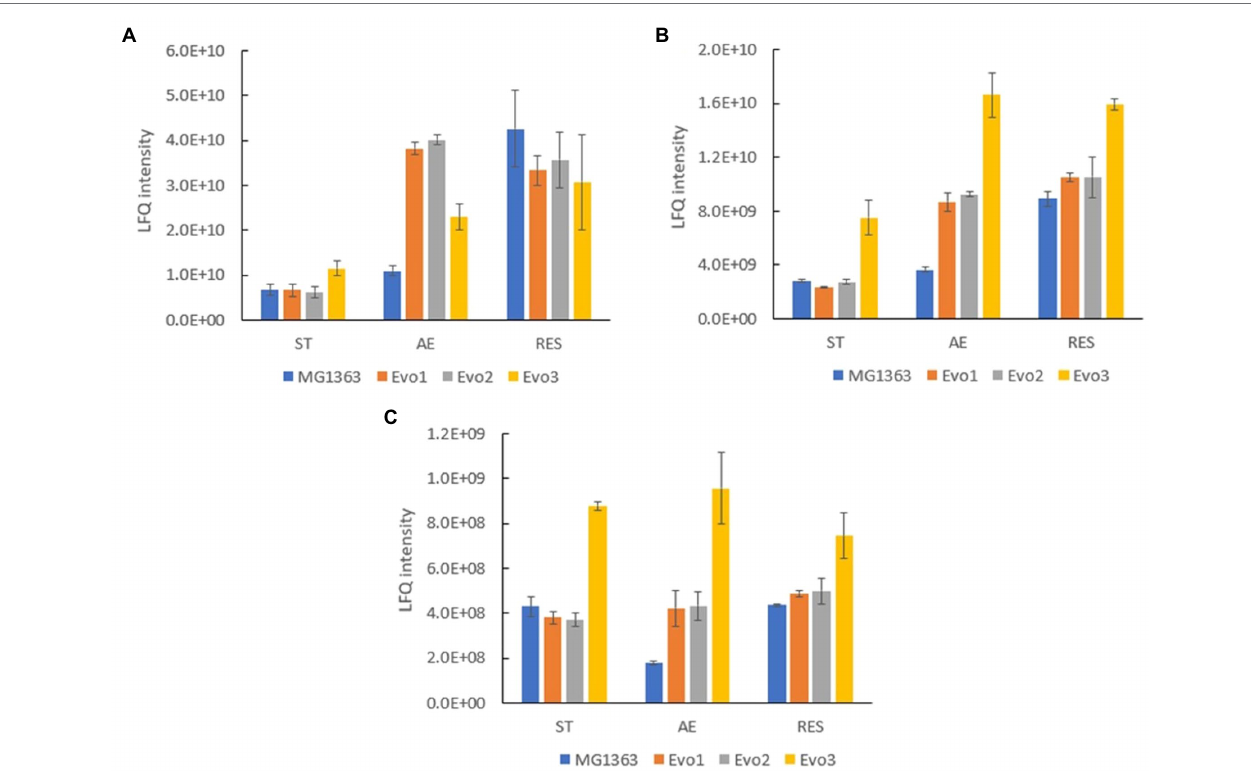
FIGURE 8 | Quantity of common differentially produced proteins in evolved strains than MG1363 under different cultivation conditions. Label-free quantitation (LFQ) intensities of (A) glyceraldehyde 3-phosphate dehydrogenase, GapA (A2RIN9), (B) universal stress protein A2, UspA2 (A2RK64), and (C) formamidopyrimidine-DNA glycosylase, MutM (A2RI84). Samples were from three independent experiments, error bars represent